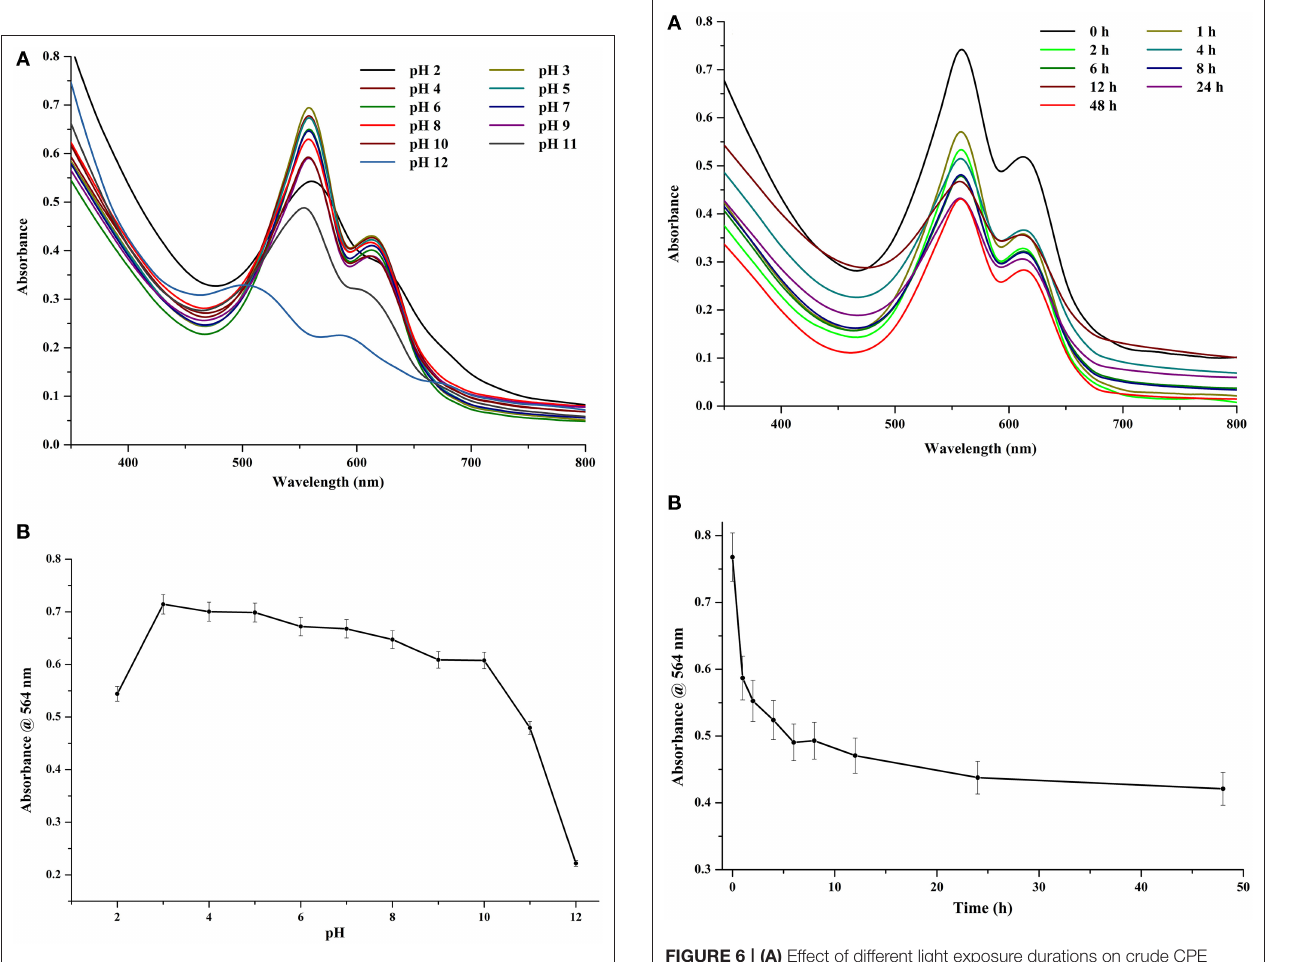
FIGURE 5 | (A) Effect of different pH on crude CPE extract. (B) Trace absorbance intensities at 564nm for CPE extract at different pH.